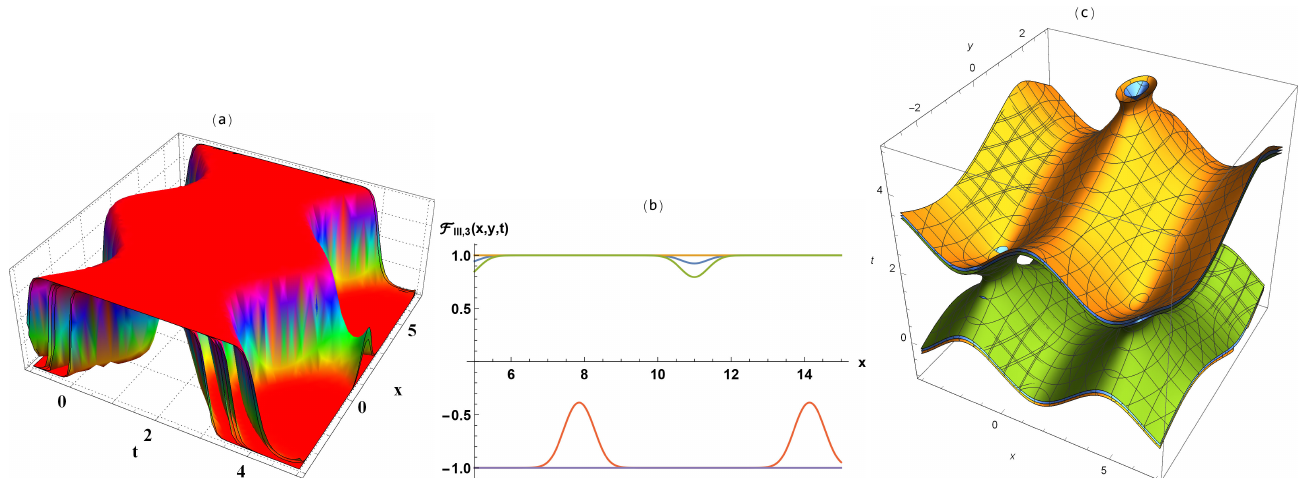
Figure 2. Computational wave solutions of Equation (16) in 3D ( a ), 2D ( b ), and contour ( c ) plots.